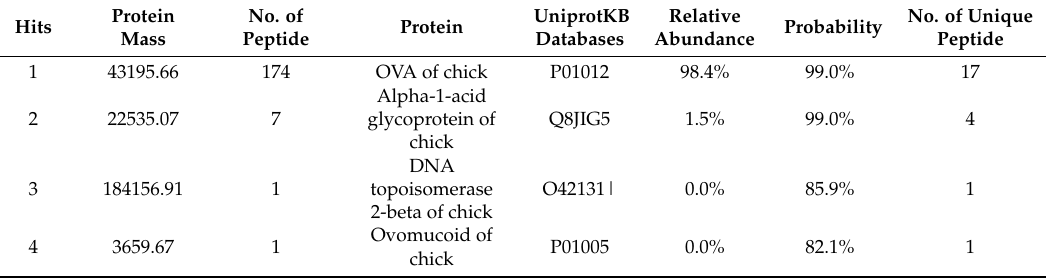
Table 5. The test results of the OVA sample by Nano LC-ESI-MS/MS.